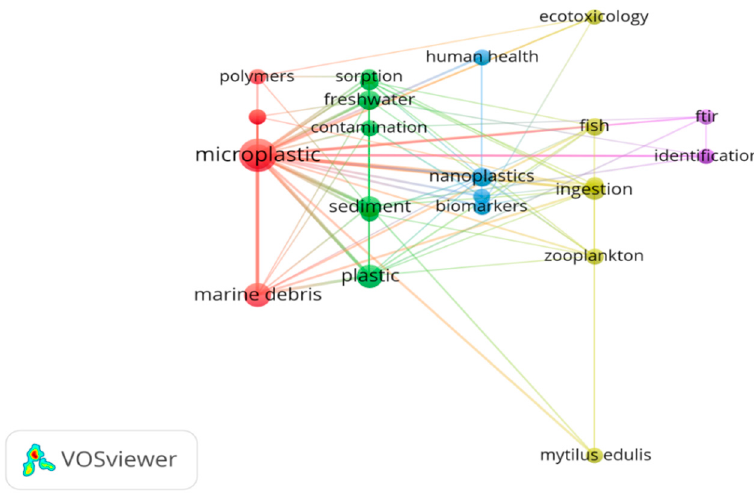
Figure 5. Co-occurrence network diagram of author keywords appearing in a minimum of five ESI highly cited papers, between 2010 and 2019.